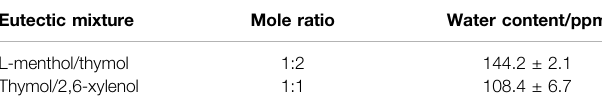
TABLE 1 | Prepared eutectic mixtures, their molar ratio, and water content. Eutectic mixture